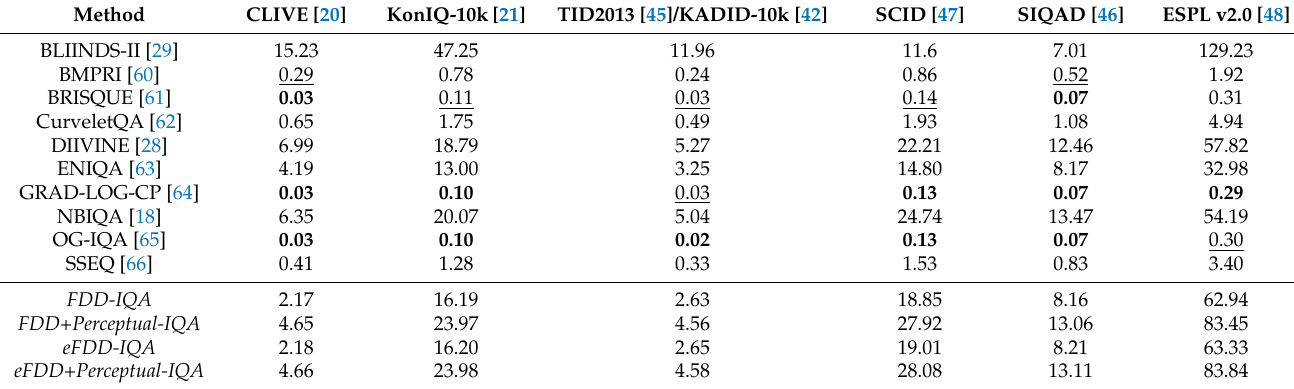
Table 14. Comparison of feature extractions’ computational times (in seconds). Best results are typed in bold, and second best results are